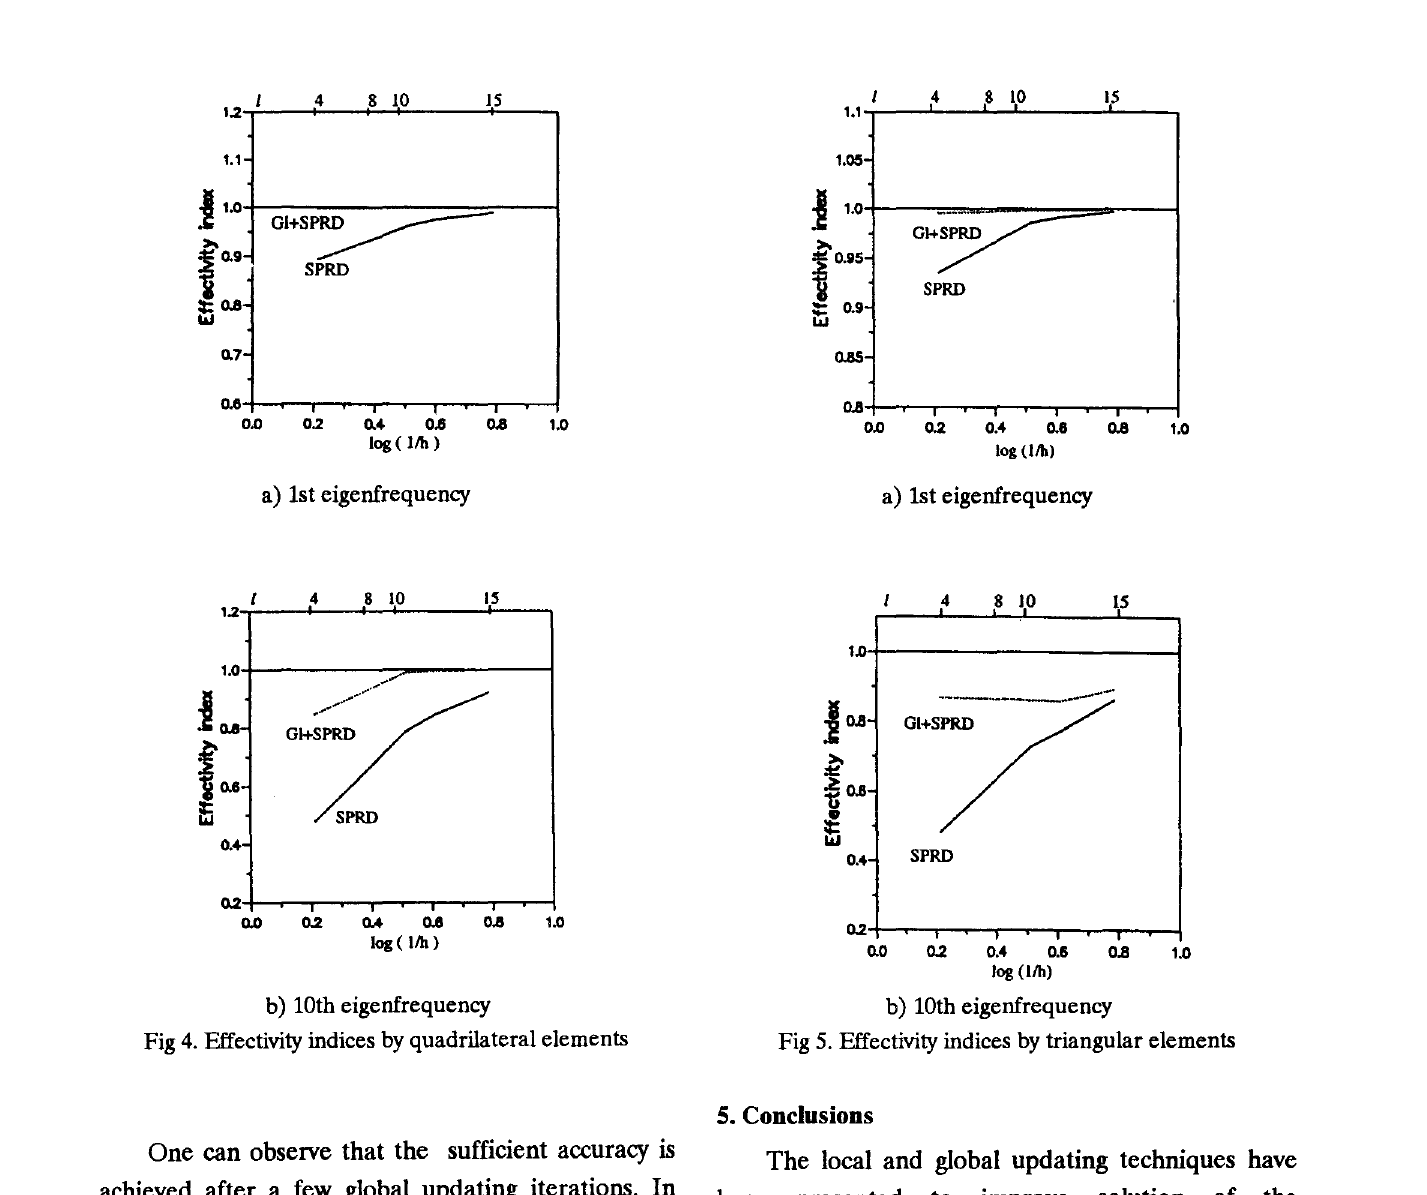
Fig 4. Effectivity indices by quadrilateral elements Fig 5. Effectivity indices by triangular